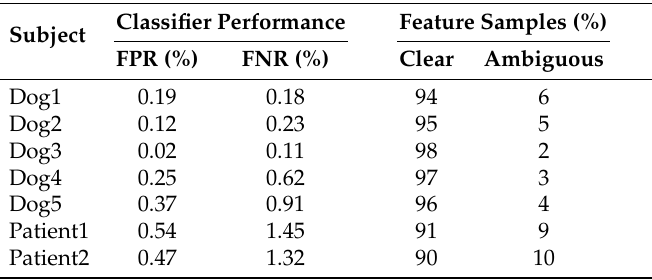
Table 15. Performance of the Support Vector Machine classifier in terms of False Positive Rate (FPR) and False Negative Rate (FNR) for all the subject’s inter-ictal dataset using set t feature set. Classifier performances of only the best iterations are